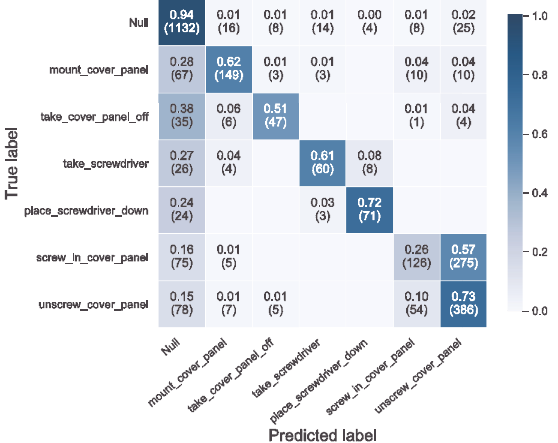
(Dn matrix of Deep Convolutional Long Short- Fig. 3. Confusion C-LSTM) on the OCA dataset. TTeerm Memory